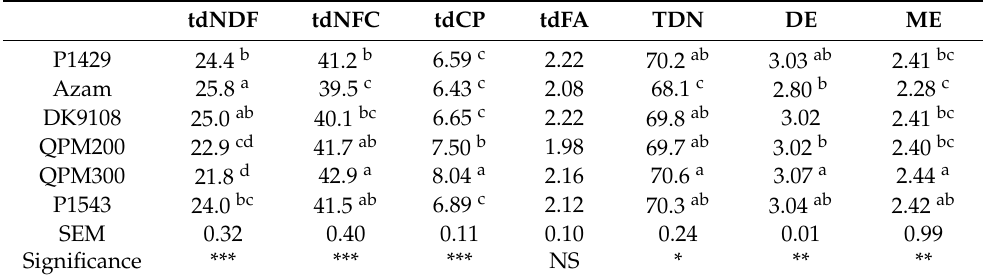
Table 7. Total digestible nutrients and estimated energy values